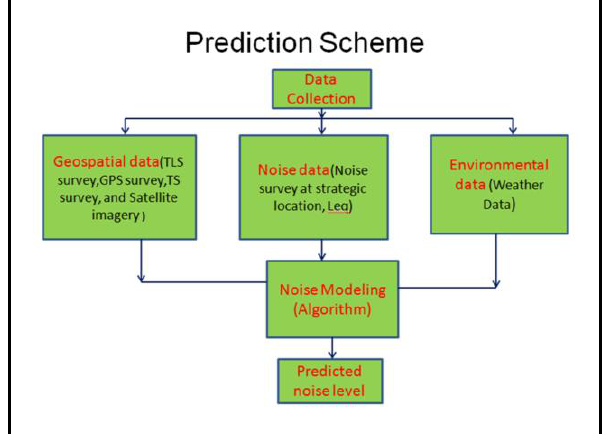
Figure 3. Methodology prediction